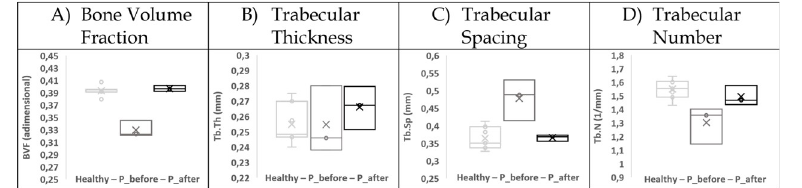
Fig 3. ROI1a extrapolated features box plot. Box plot for each extrapolated feature for the control reference (Healthy), patient before (P_before) and after (P_after) one year of anti-TNF α treatment in the trabecular region where the quadricep tendon attaches the patella